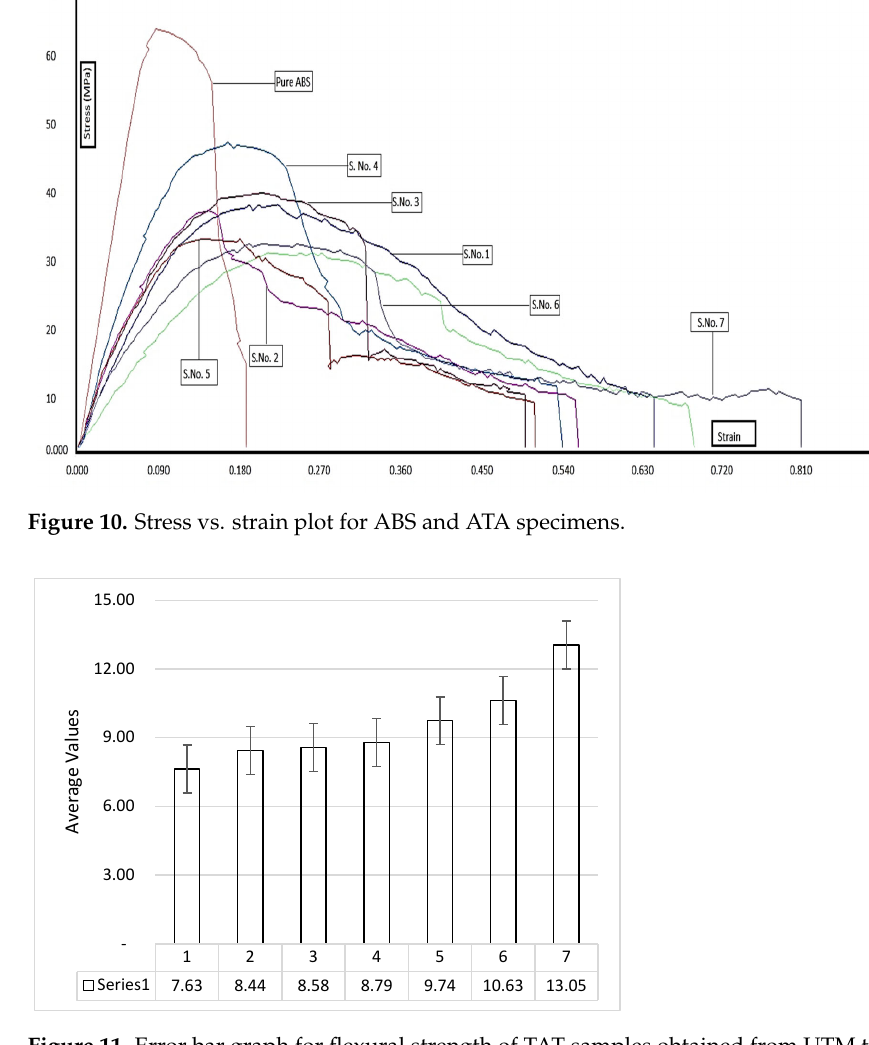
Figure 11. Error bar graph for flexural strength of TAT samples obtained from UTM testing .